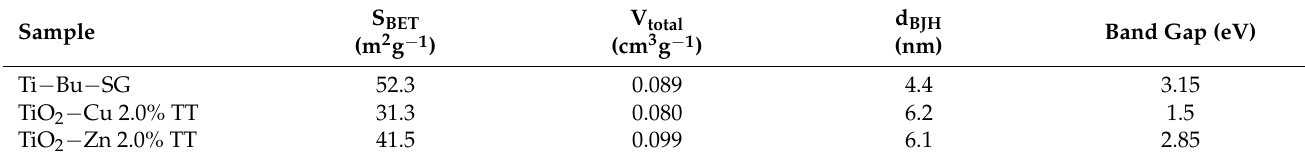
Table 6. The specific BET surface areas (S BET ), total pore volume (V total ), average pore diameter (d) and band gap values of the samples.